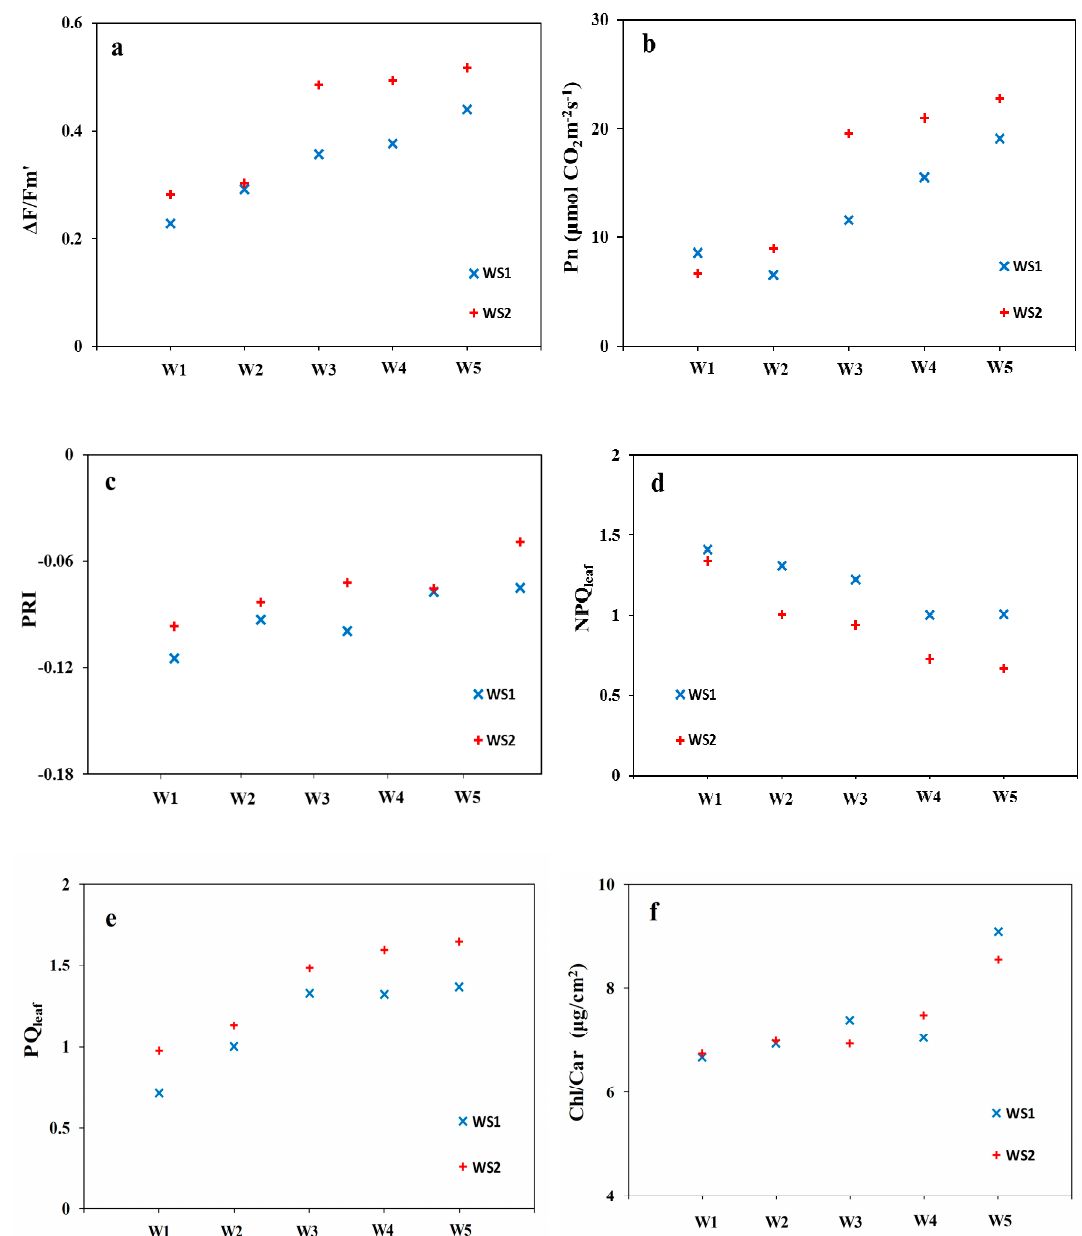
Figure 3. The plots with five different water stress levels are indicated by colors, and two groups of data are shown in this experiment. WS1 and WS2 represent the first and second group of treatments, respectively. ( a ) The variations of actual quantum yield of PSII ( Δ F/F m ′ ), ( b ) net photosynthetic rate ( P n ), ( c ) photochemical reflectance index (PRI), ( d ) non-photochemical quenching (NPQ leaf ), ( e ) photochemical quenching, and ( f ) the ratio of chlorophyll to carotenoid (Chl/Car) at different water stress levels. W1: 20% FC < SWC < 35% FC, W2: 35% FC < SWC < 45% FC, W3: 50% FC <SWC < 60% FC, W4: 65% FC < SWC < 75% FC, W5: 80% FC < SWC < 90% FC.